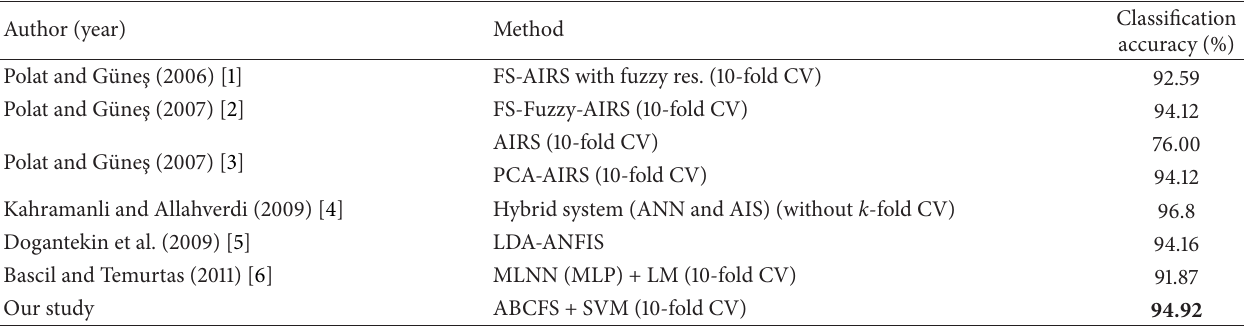
Table 8: Classification accuracies obtained by our method and other classifiers for the hepatitis dataset.